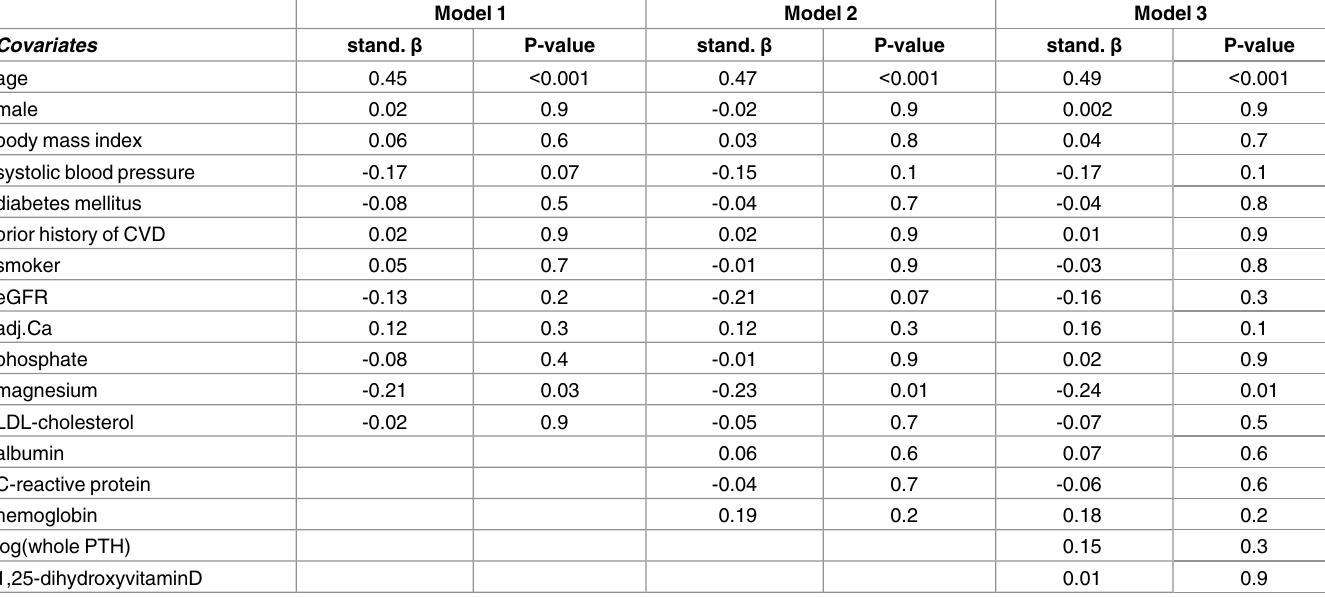
Table 2. Multivariate associations between exponential-transformed density of CAC and clinical factors.